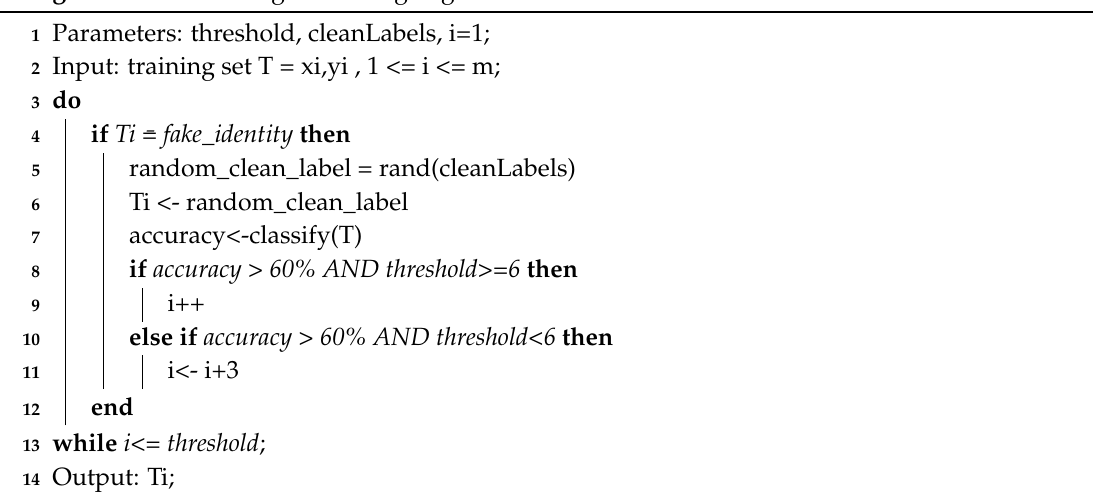
Algorithm 1: Poisoning Relabeling Algorithm.